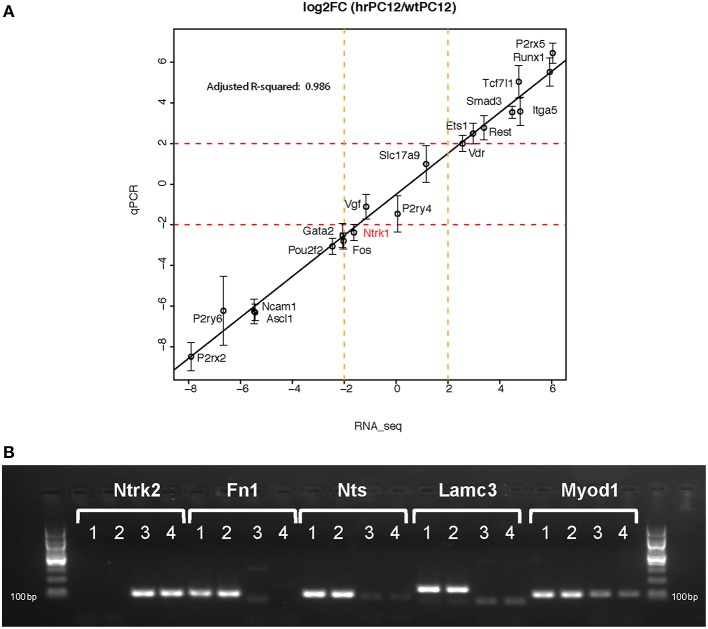
RT-qPCR Validation. The Figure compares the wtPC12/hrPC12 values of 24 genes, obtained by RT-qPCR duplicate samples, to the values obtained by RNA-Seq. Panel (A) illustrates the close matching results of 19 genes (qPCR values are mean of log2 fold change ± SD; Pearson correlation coefficient, R2 = 0.986). Panel (B) shows the PCR message results of 5 genes exhibiting in one clone values too little to be appropriately appreciated by RT-qPCR. The samples were only run on gels (lane 1 and 2 = hrPC12; 3 and 4 = wtPC12). The results confirm Ntrk2 (the TrkB receptor) to be repressed, and the other 4 genes to be up-regulated in the hrPC12 cells (RNA-Seq ratios: Ntrk2, −5.2; Fn1, 7.41; Nts, 9.44; Lamc3, 7.47; and Myod1, 8.18).